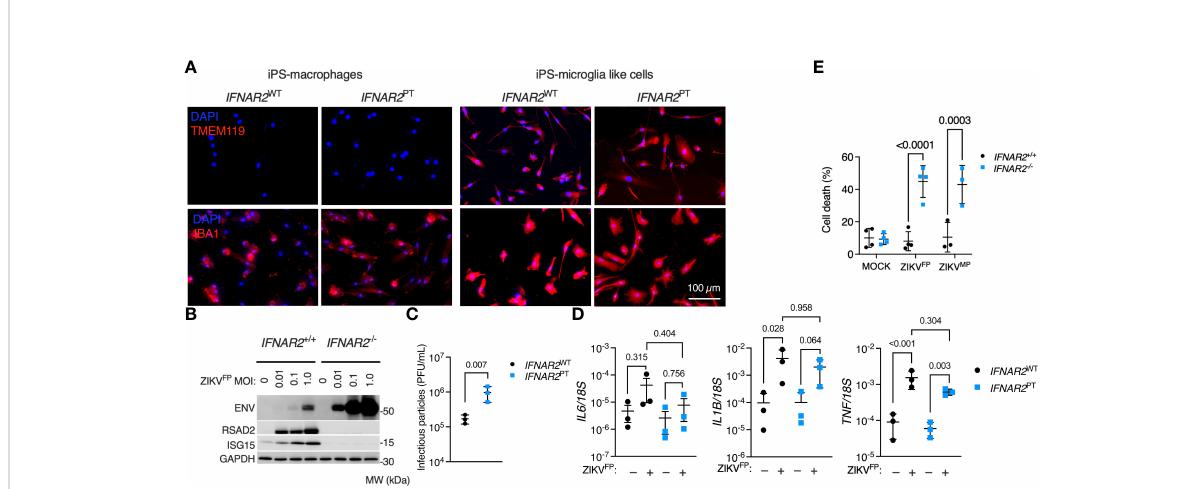
FIGURE 9 Enhanced ZIKV infection and CPE in IFNAR2 -de fi cient iPS-microglia-like cells. (A) Immuno fl uorescence analysis of microglial markers IBA1 and TMEM119 in IFNAR2 PT (PT clone 11) and IFNAR2 WT (WT2) iPS-M f and iPS-microglia-like cells (iPS-MGLs), representative of repeat experiments in G2, B5_2, G8 and F8 lines. Scale bar = 100 m m. (B) Immunoblot of ENV, RSAD2, ISG15, GAPDH in ZIKV FP -infected IFNAR2 +/+ (F8) and IFNAR2 -/- (B5_2) iPS-MGLs at 72 h.p.i., representative of n = 3 independent experiments in IFNAR2 PT [clones 6 and 11] and IFNAR2 WT [WT2]). (C) Plaque assay on Vero cells of ZIKV infectious particles in supernatants (48 h.p.i. ZIKVFP MOI = 1, n = 3 independent experiments in IFNAR2 WT (WT2) and IFNAR2 PT (clone 6) iPS-microglia-like cells. Mean ± SD, t test. (D) RT-PCR quanti fi cation of IL6 , IL1B and TNF relative to 18S (24 h .p.i. ZIKV FP MOI = 1, n = 3 independent experiments in IFNAR2 WT [WT2] and IFNAR2 PT [clones 6 and 11]) microglia- like cells. Mean ± SD, ANOVA with Sidak ’ s test for multiple comparisons. (E) Cell viability assay (72 h.p.i. ZIKV FP MOI = 1.0 [n = 4 independent experiments] or ZIKV MP MOI = 1.0 [n = 3 independent experiments]) in IFNAR2 -/- (B5_2), IFNAR2 PT (clone 6), IFNAR2 +/+ (F8) and IFNAR2 PT (WT2) iPS-MGLs. Mean ± SD, ANOVA with Sidak ’ s test for multiple